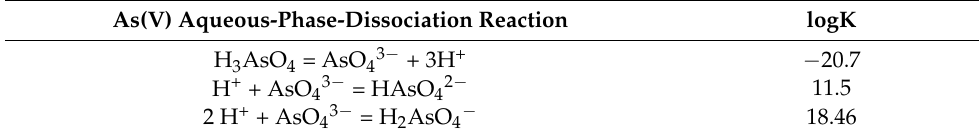
Table 1. Speciation of As(V) in aqueous